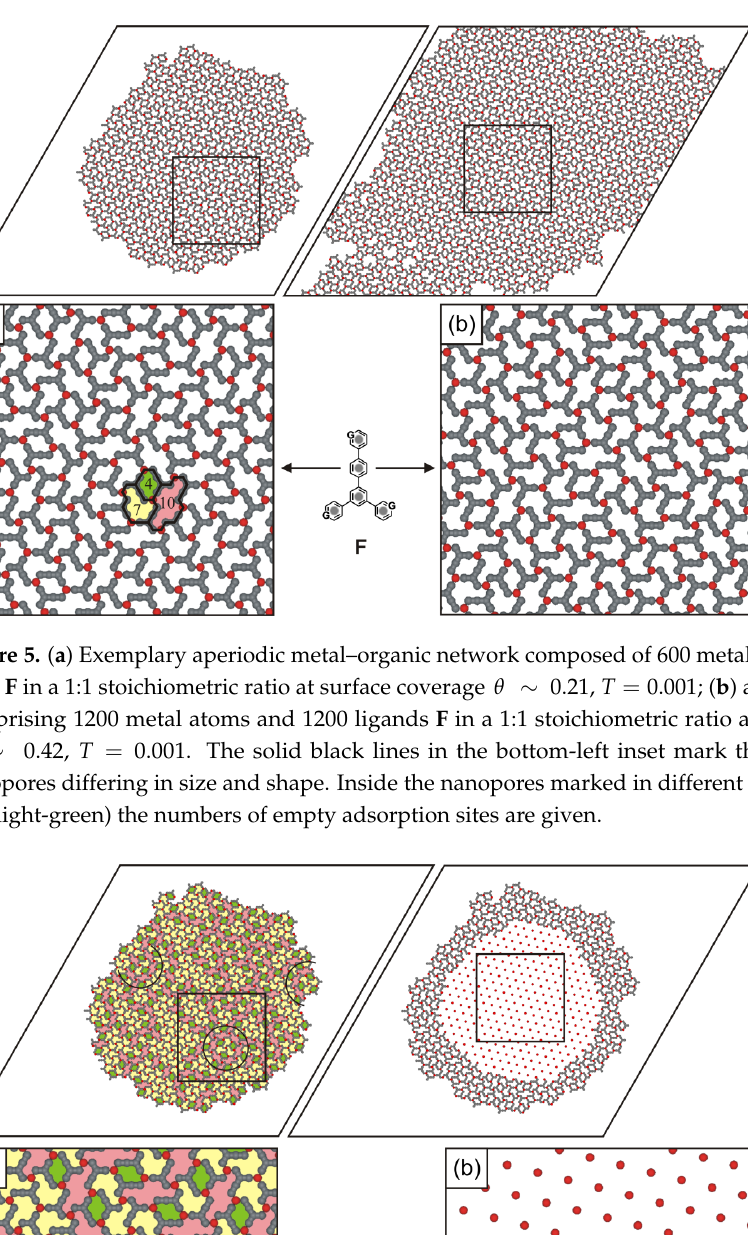
independent system replicas).